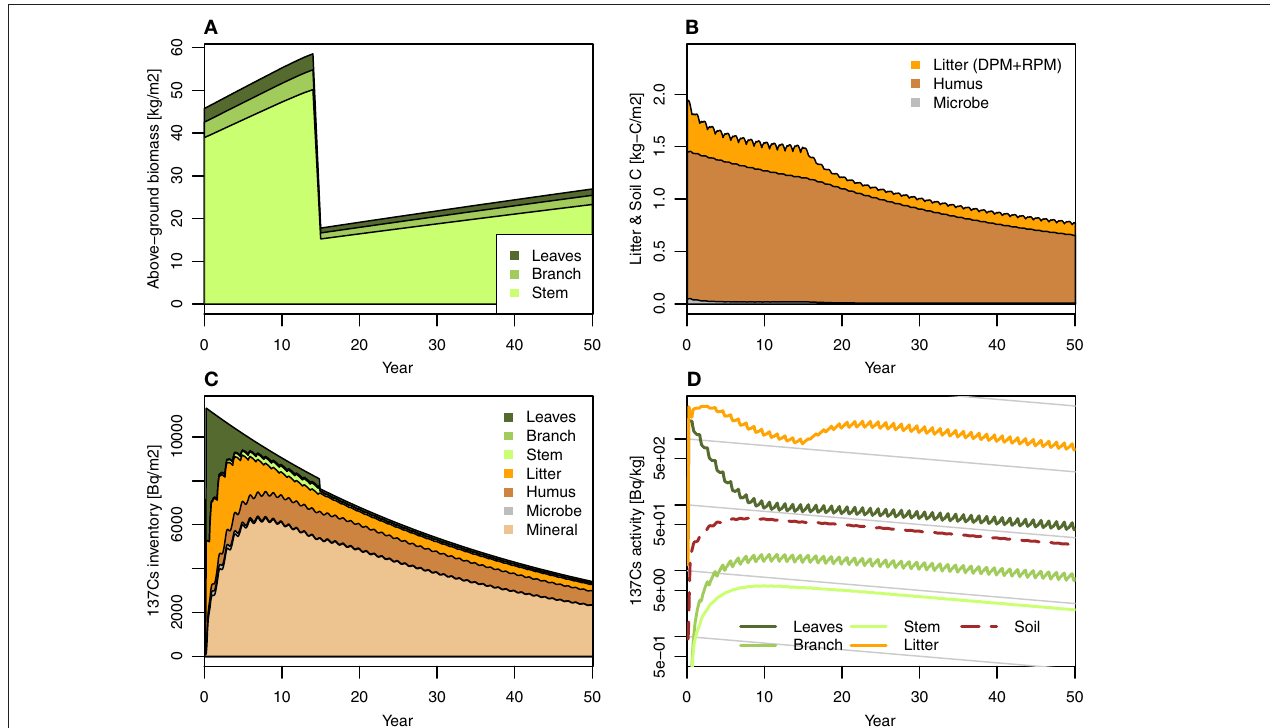
FIGURE 3 | Simulation case 2: Intensity thinning (70%) management, at 15 years after fallout event. (A) Forest biomass (annual), (B) litter layer and soil C, (C) 137 Cs inventory, and (D) 137 Cs activity.